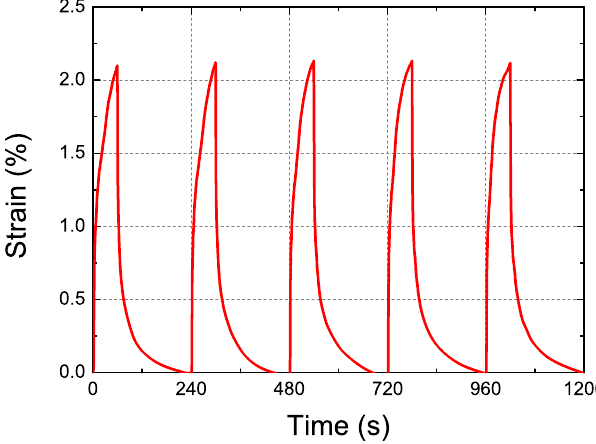
Figure 9. Measured axial strain in cylindrical DEA as function of time: periodic electrical stimuli with amplitude of 9.9 kV and duty cycle of 25%. Each cycle of time-domain response included charging process of 60 s and discharging process of 180 s. Cylindrical DEA extended during charging process and contracted during discharging process.